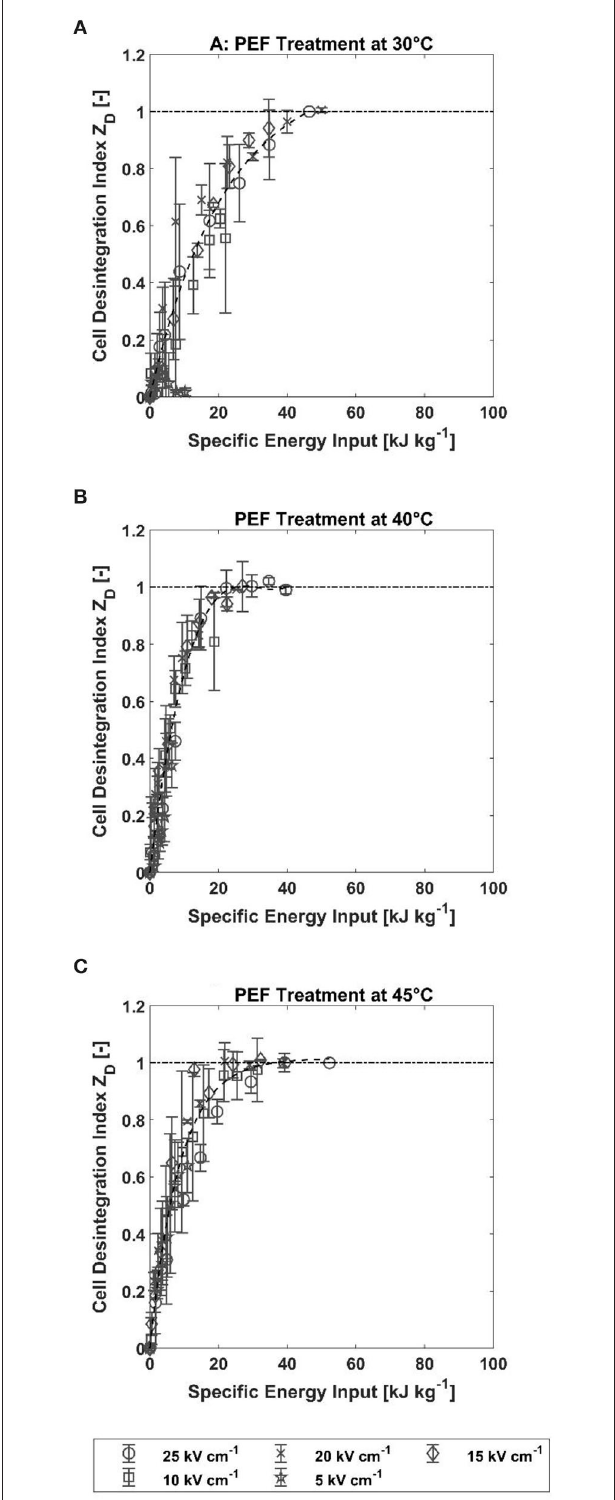
FIGURE 4 | Cell disintegration index Z D as a function of electrical energy input for treatment temperature of 30, 40, and 45 ◦ C. The error bars indicate the standard deviation between the mean values of two independent measurements. (A) PEF treatment at 30 ◦ C. (B) PEF treatment at 40 ◦ C. (C) PEF treatment at 45 ◦